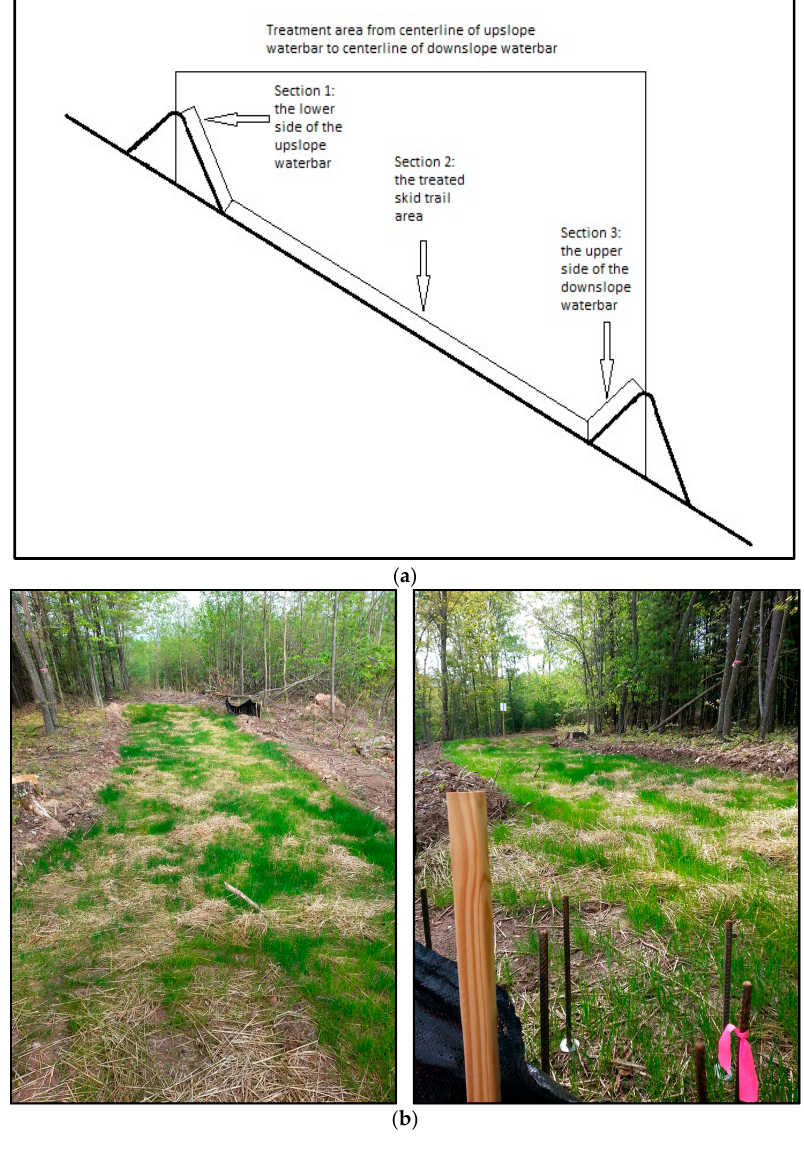
Figure 5. ( a ) Profile of skid trail treatment. Sections 1 and 2 (lower side of upslope waterbar and skid trail surface) were modeled together; Section 3 (upper side of downslope waterbar) was modeled separately; ( b ) Photographs of a Mulch treatment from the upslope waterbar looking down toward treatment, downslope waterbar, and sediment trap (first photograph), and from the sediment trap looking upslope to waterbar at top of treatment (second photograph).